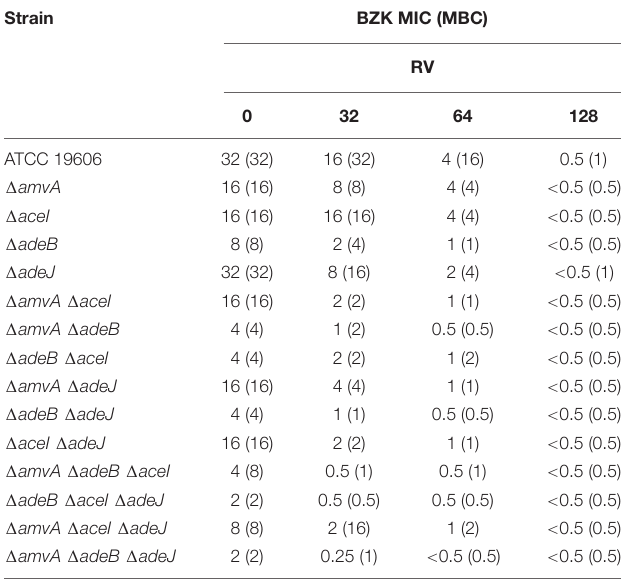
TABLE 7 | RV effect on BZK MIC (mg/L) and MBC (mg/L) in A. baumannii ATCC 19606 parental strain and EP deletion mutants. Strain BZK MIC (MBC)